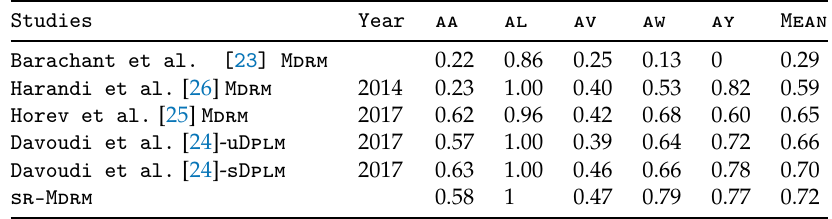
Table 4. The performance of proposed approach and existing Riemannian geometry based approaches on Dataset IVa of BCI Competition III in terms of kappa values.